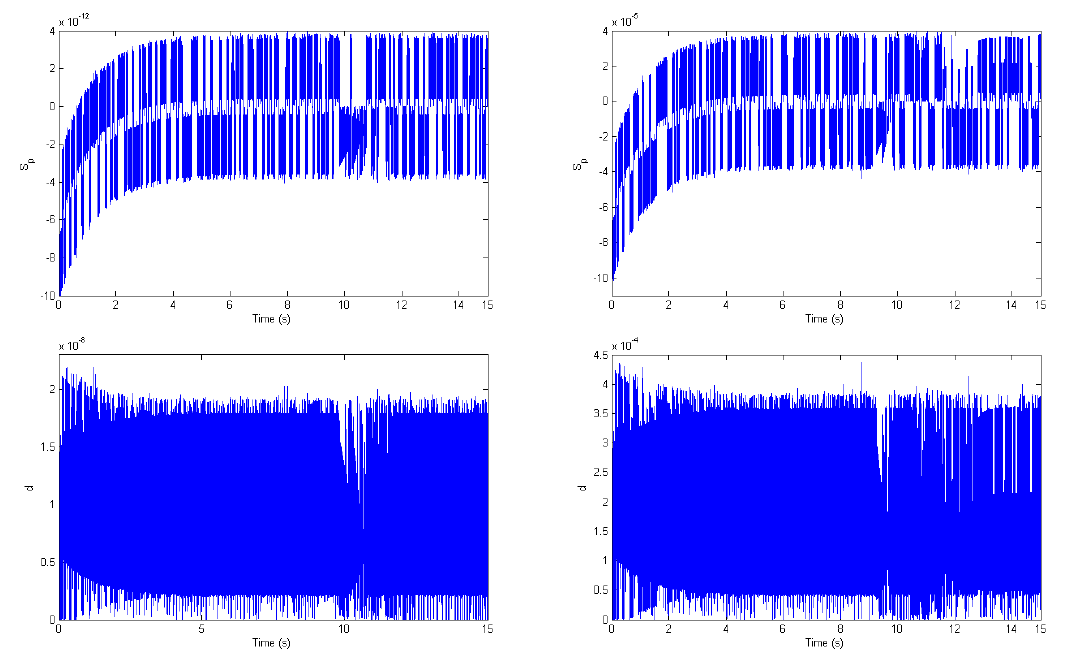
Fig. 3: S and d error values on T2FSMC (the firefly algorithm (left side) and the bisection algorithm (right side)) p